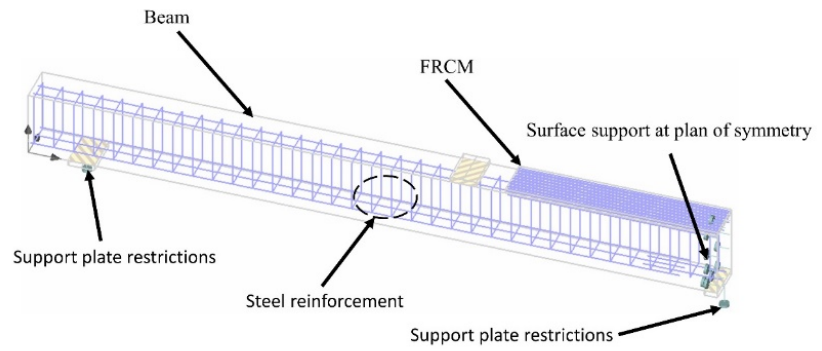
Figure 16. Numerical model elements and boundary conditions.